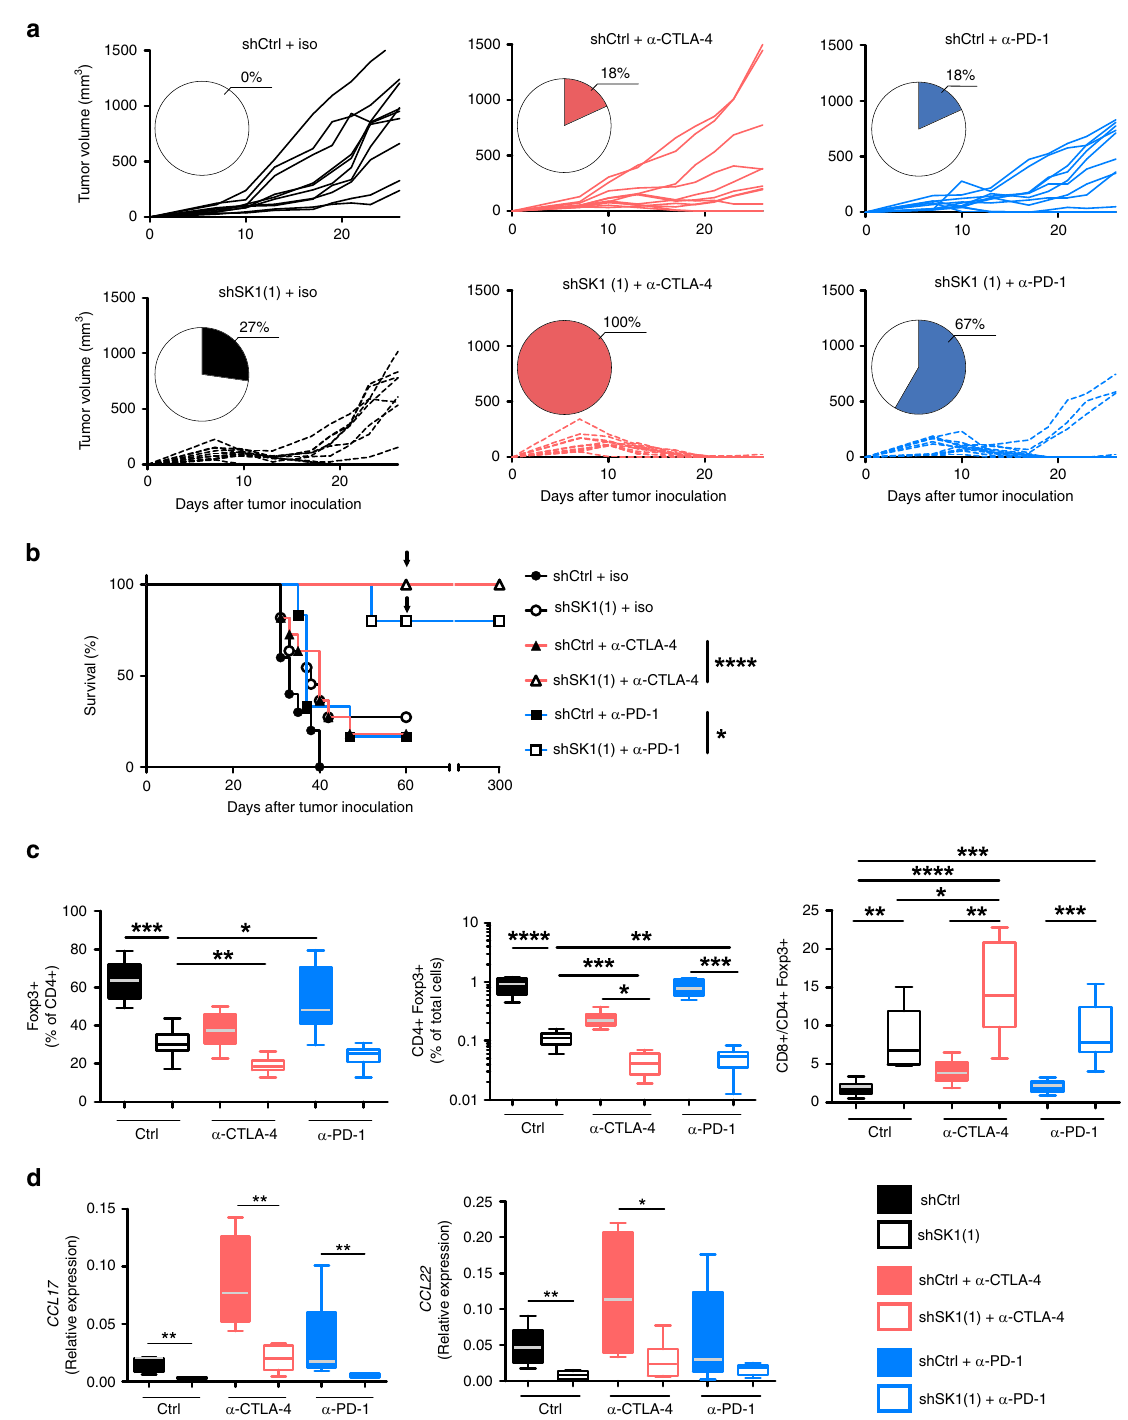
Fig. 4 SK1 inhibition enhances the ef fi cacy of anti-CTLA-4 or anti-PD-1 therapy. Control shRNA (shCtrl) or SK1-targeted shRNA (shSK1(1)) Yumm cells were injected on day 0, and then mice were treated with isotype (iso) control antibody (black lines; shCtrl n = 10 mice, shSK1(1) n = 11 mice), anti-CTLA-4 (red lines; shCtrl n = 11 mice, shSK1(1) n = 11 mice), or anti-PD-1 (blue lines; shCtrl n = 11 mice, shSK1(1) n = 12 mice). a Individual growth curves are depicted for each tumor. Inserts: numbers indicate percentage (%) of tumor-free mice at day 26. b Kaplan – Meier survival curves with log-rank test (iso, circles and black lines; anti-CTLA-4, triangles and red lines; anti-PD-1, squares and blue lines. Full and empty symbols correspond to shCtrl and shSK1(1), respectively). The arrow indicates a second orthotopic injection of shSK1 cells. c Percentages of CD4 + Foxp3 + among CD4 T cells (left panel) or total cells (middle panel) and CD8/CD4 + Foxp3 + T-cell ratio (right panel) at day 11 (iso, black/white boxes; anti-CTLA-4, red boxes; anti-PD-1, blue boxes. Full and empty symbols correspond to shCtrl and shSK1(1), respectively) (n = 9 mice/group). d CCL17 and CCL22 mRNA expression in tumors. Results are representative of two independent experiments ( n = 5 mice/group). c , d Samples were compared using Kruskal – Wallis test with Dunn ’ s